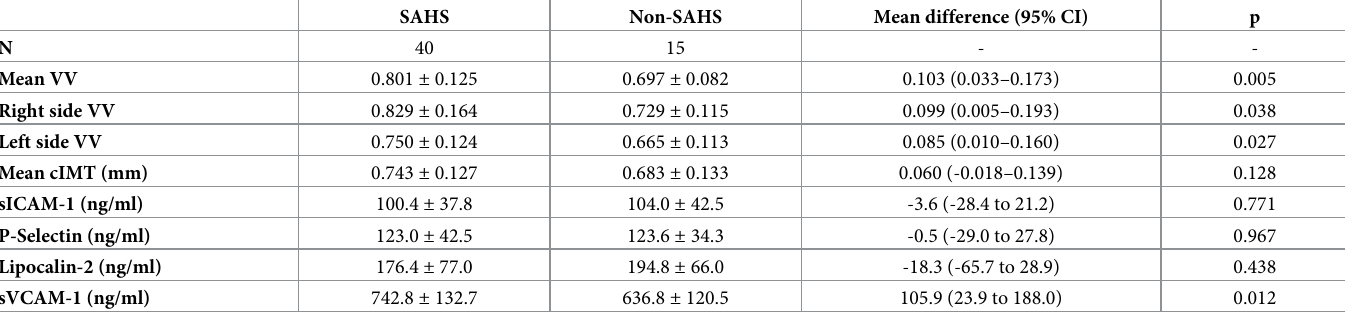
Table 2. Carotid adventitial VV density, cIMT and serum biomarkers of endothelial damage of the individuals included in the study according to the presence of sleep apnea-hypopnea